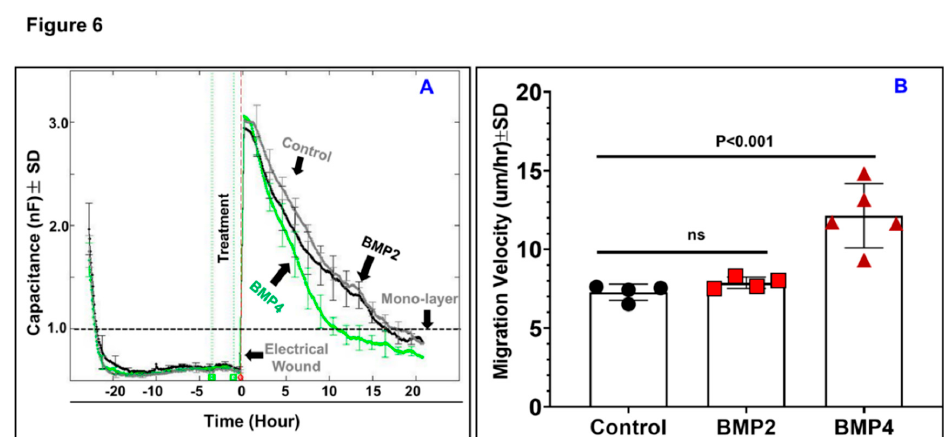
Figure 6. Migration assay of ARPE-19 cells using ECIS. ( A ) ARPE-19 cells treated with BMP2 and BMP4 (50 ng/mL each) versus control. After electrical wound creation at vertical dotted red line, migration of ARPE-19 cells was measured by their ability to re-form a monolayer indicated by capacitance of 1nF (Horizontal dashed line). ( B ) The migration velocity calculated by dividing the total distance that ARPE-19 cells migrated on the radius of the electrode which is 125-µm divided by the time required for recovering 100% of normalized capacitance, the recovery point. The cells treated with BMP4 re-formed a mono-layer significantly faster than BMP2 and the control groups. Meanwhile, migration of the BMP2 treated ARPE-19 cells showed no significant di ff erence versus the control group. Black circles: control; Red squares: BMP2; Red Triangles: BMP4. Results are presented as mean ± SD; n = 4–5 per group; ns =